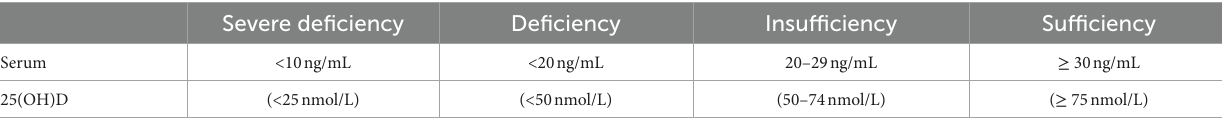
TABLE 1 Suggested cut-off values for the definition of vitamin D status based on circulating levels of 25(OH)D (74). Severe